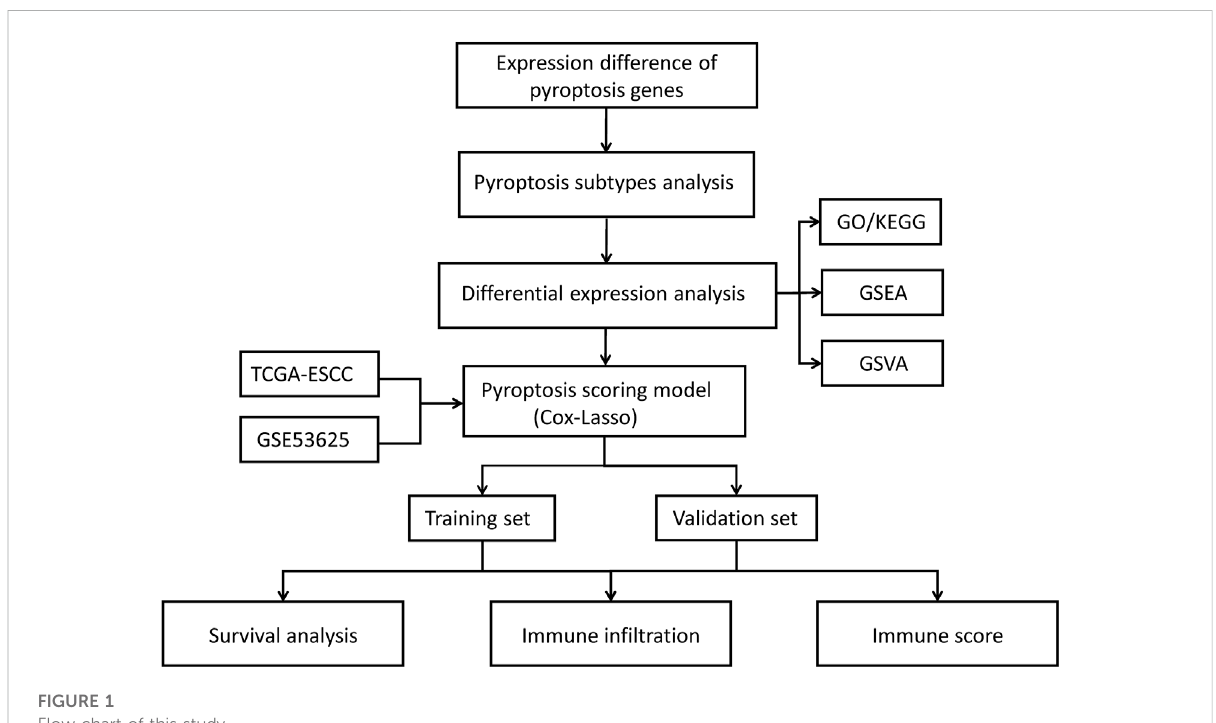
FIGURE 1 Flow chart of this